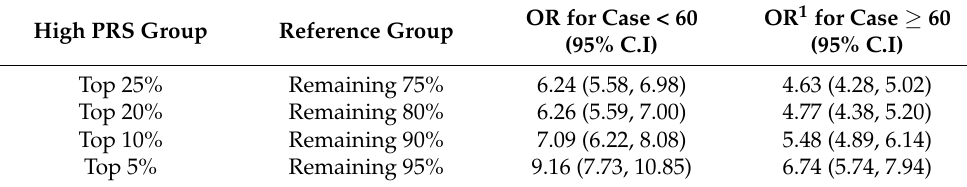
Table 5. Risk of high PRS groups for development of cataracts for younger cases (<60) and older cases ( ≥ 60).